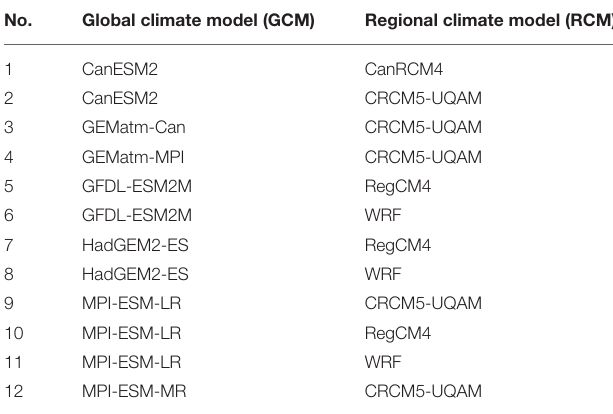
TABLE 1 | The 12 NA-CORDEX GCM-RCM combinations used in this study.